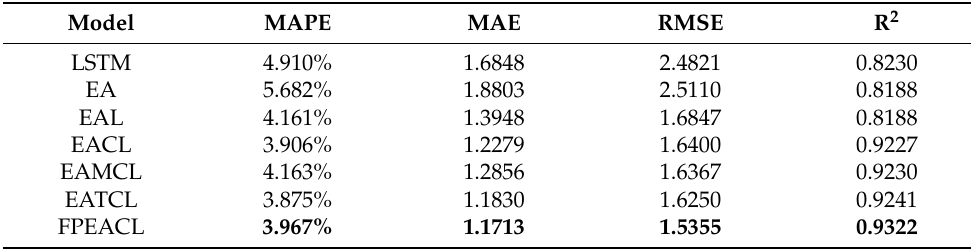
Table 4. Comparison of monthly load initial forecast results indicators for the whole year between FPEACL and other models.